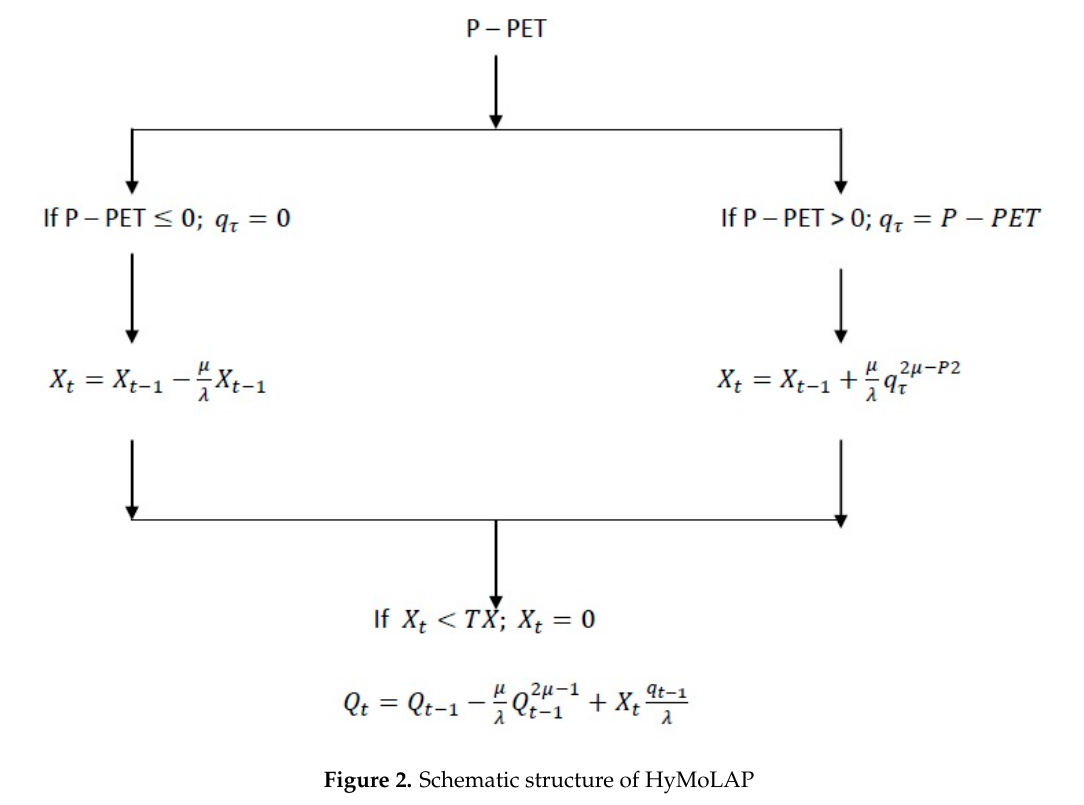
Figure 2. Schematic structure of HyMoLAP